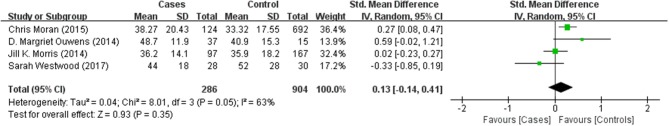
Forest plot comparing CSF p-Tau levels in subjects with (pre)diabetes and controls.